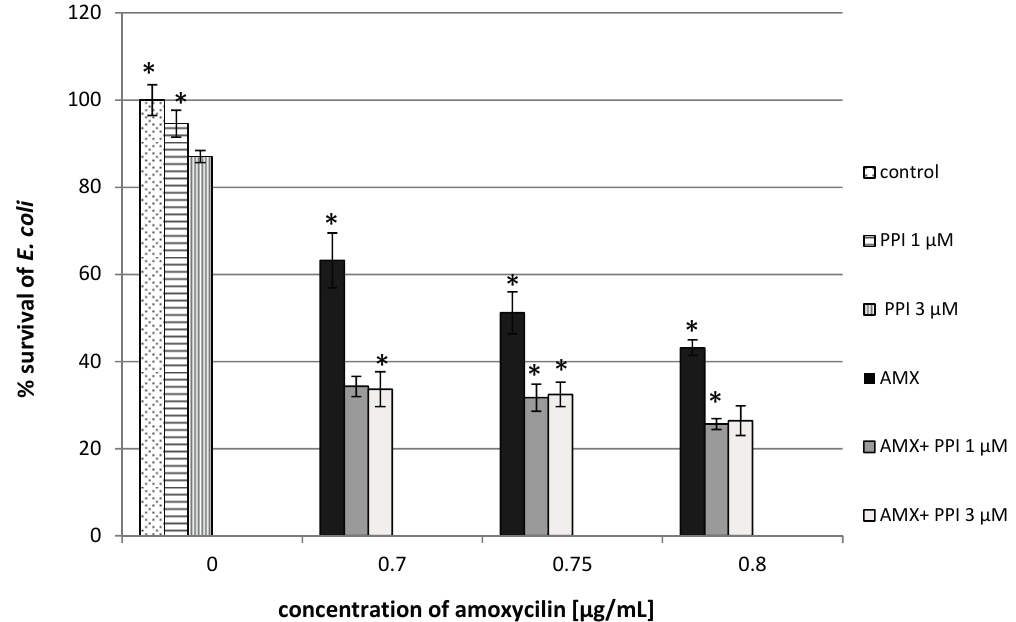
Figure 4. Growth of E. coli after 24 h incubation with unmodified poly(propylene imine) dendrimers (PPI) or/and amoxicillin. Each bar represents and the mean and SD of n ≥ 3 wells from three independent experiments. The comparison was made using one-way analysis of Student’s t -test. * p < 0.05 vs. control